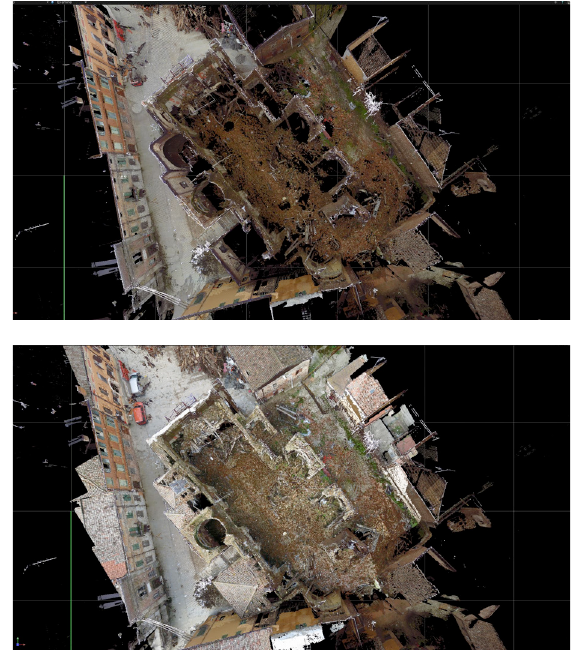
Figure 12: Above, laser scanner point clouds.